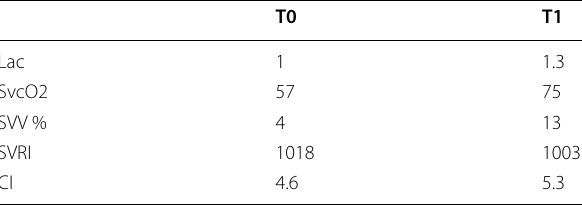
LAC lactate (mmol/L), SvcO2 venous central oxygen saturation (%), SVV% stroke volume variation (%), SVRI systemic vascular resistance index (dyn s/cm 5 m 2 ), CI